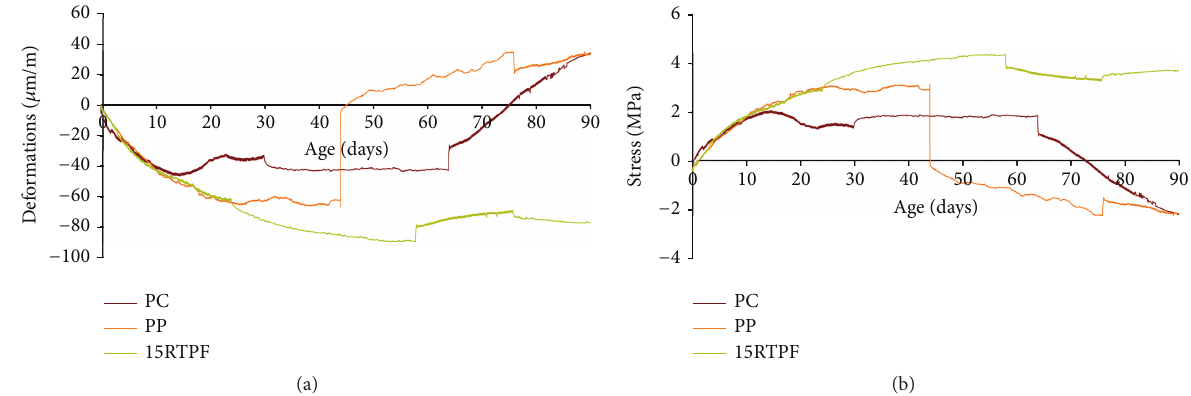
Figure 7: Restrained shrinkage: (a) stress and (b) deformations for ring specimens.